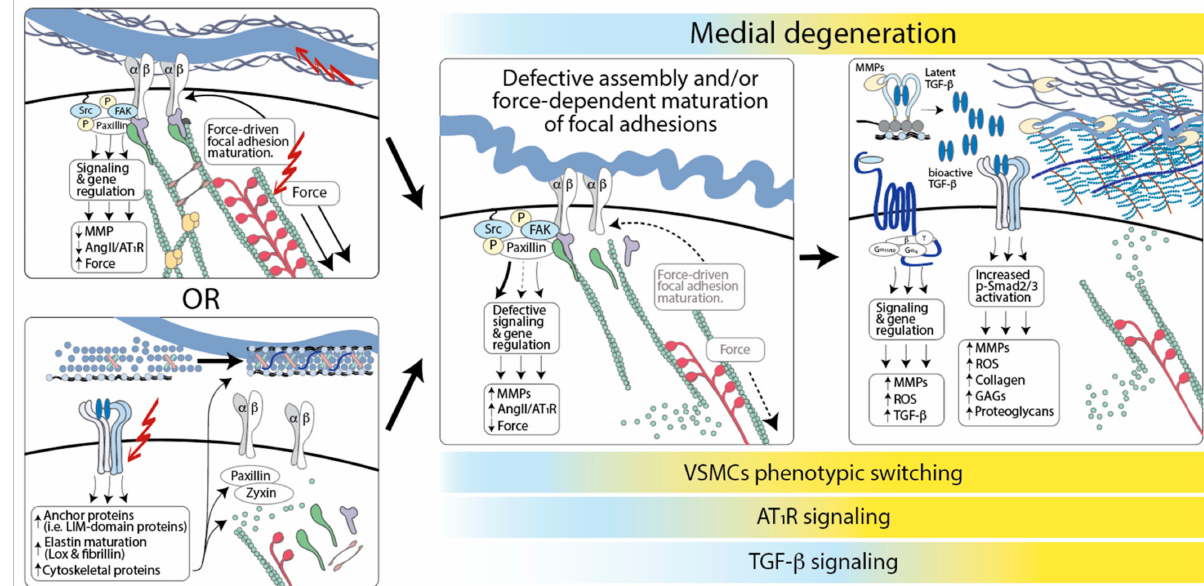
Figure 2. A model for hereditary aneurysm pathogenesis. Defective assembly of connections between elastic fibers and VSMCs initiates their phenotypic switch toward a proteolytic phenotype that promotes medial degeneration. The pathogenic process can be initiated by genetic mutations (red lightening) that directly target ECM structures or intracellular components necessary for the assembly/function of focal adhesions, including cytoskeletal components necessary for force-dependent focal adhesion maturation. It can also be initiated by mutations that target signaling pathways, such as TGF- β and Notch signaling, which modulate the expression of components of the focal adhesion machinery (ECM components, adaptor/anchoring proteins such as zyxin and paxillin, and actin-binding proteins such as Sm22). Opportunity to establish proper connections between VSMCs and the ECM may be developmentally restricted, given that adult VSMCs have limited ability to elaborate and organize components of the elastic fibers. Dysfunctional signaling downstream of focal adhesions would promote phenotypic switching, inducing a downregulation of contractile proteins, upregulation of metalloproteinases, and other matrix proteins, such as thrombospondin-1, that positively regulate AT 1 R and TGF- β signaling, further exacerbating ECM pathogenic remodeling. The activation of AT 1 R signaling and AT 1 R-dependent upregulation of TGF- β signaling would result in the deposition of collagen, accumulation of proteoglycans, and production metalloproteinases and reactive oxygen species (ROS). TGF- β signaling is modeled as protective at early stages of disease, when it may promote the restoration of ECM–VSMC interaction, and progressively more pathogenic when the establishment of ECM–VSMC interaction is no longer developmentally possible, and TGF- β promotes the deposition of proteoglycans and glycosaminoglycans, and production of